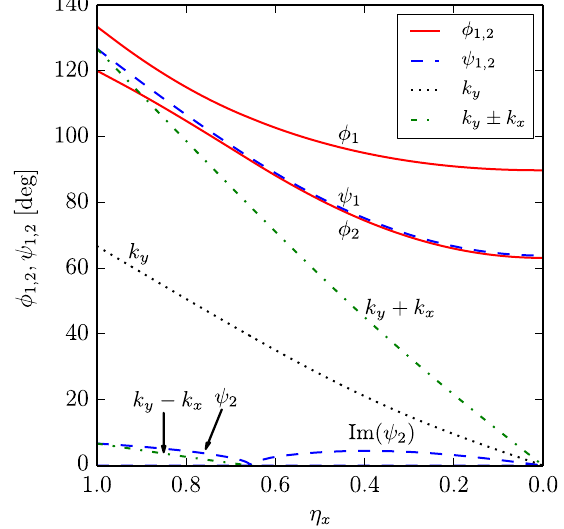
FIG. 2. Elliptical beam case, k 0 ;x ¼ 60 °, k 0 ;y ¼ 66 . 7 ° and ϵ = ϵ ¼ 2 : Phase shifts of coherent even modes ϕ x y modes ψ 1 ; 2 versus tune depression in x in a constant focusing channel.